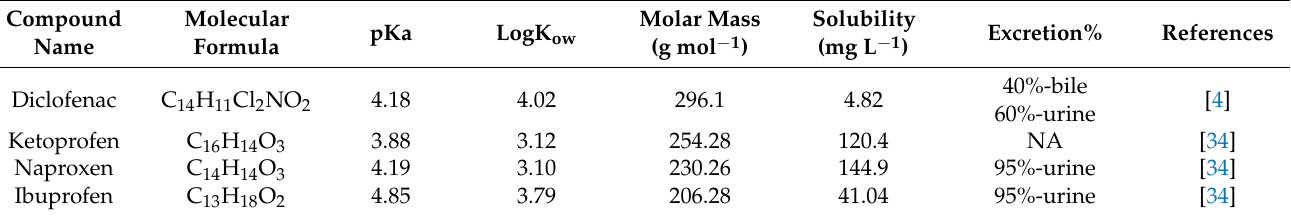
Table 1. Physico-chemicals properties of selected